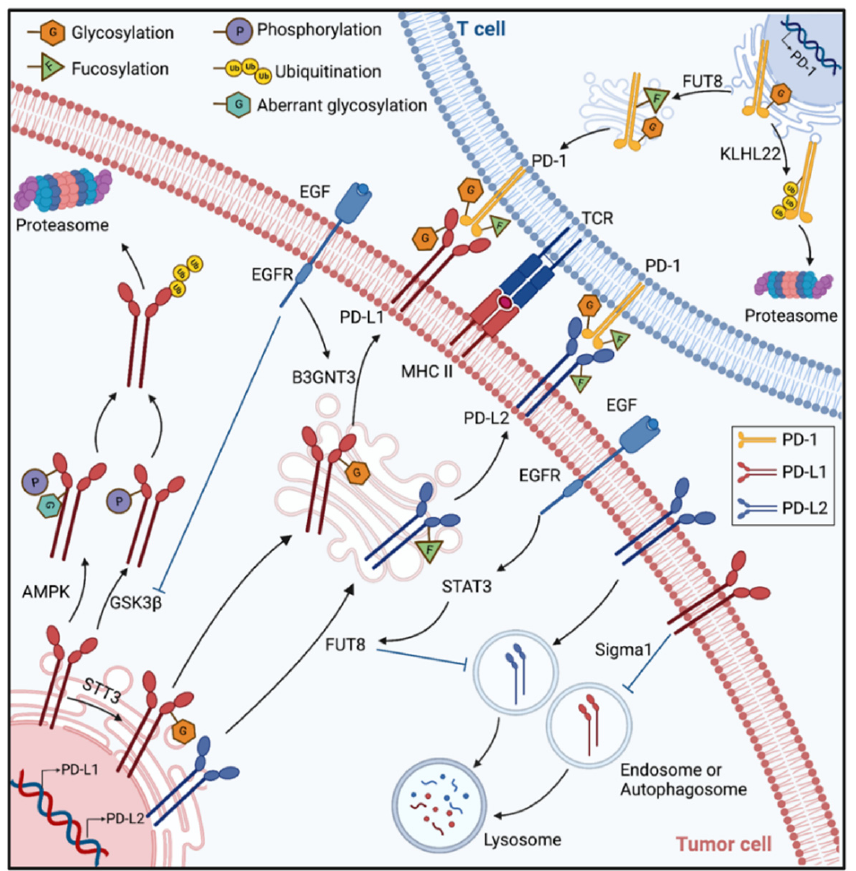
Figure 3. The mechanisms of PD-1 and PD-L1/2 binding and degradation associated with glycosylation. Created with BioRender.com on 14 October 2022.